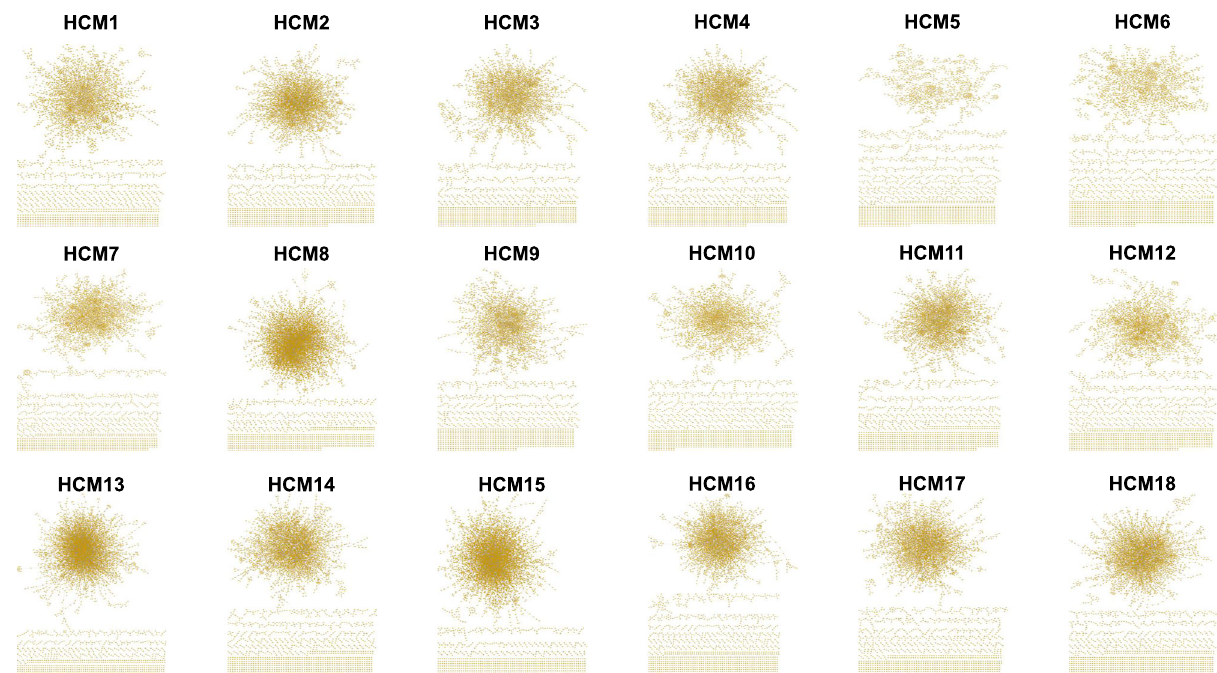
Fig. 2 Individual protein – protein interaction networks (reticulotypes) for all HCM patients. The transcriptomic pro fi le of anterior septal myectomy specimens from patients with hypertrophic cardiomyopathy (HCM) ( N = 18) was analyzed using a two-step method that included a correlation matrix and protein – protein interaction (PPI) analysis from the consolidated human interactome, as outlined in Fig. 1. The derivative individualized patient networks varied in topology (median = 3629 [2474 min, 5031 max] number of nodes, representing proteins) and complexity (median = 3696 [2014 min, 6626 max] number of edges, representing links or physical protein – protein interactions between nodes), and were used in further analyses informing patient-speci fi c HCM pathophenotypic and clinical